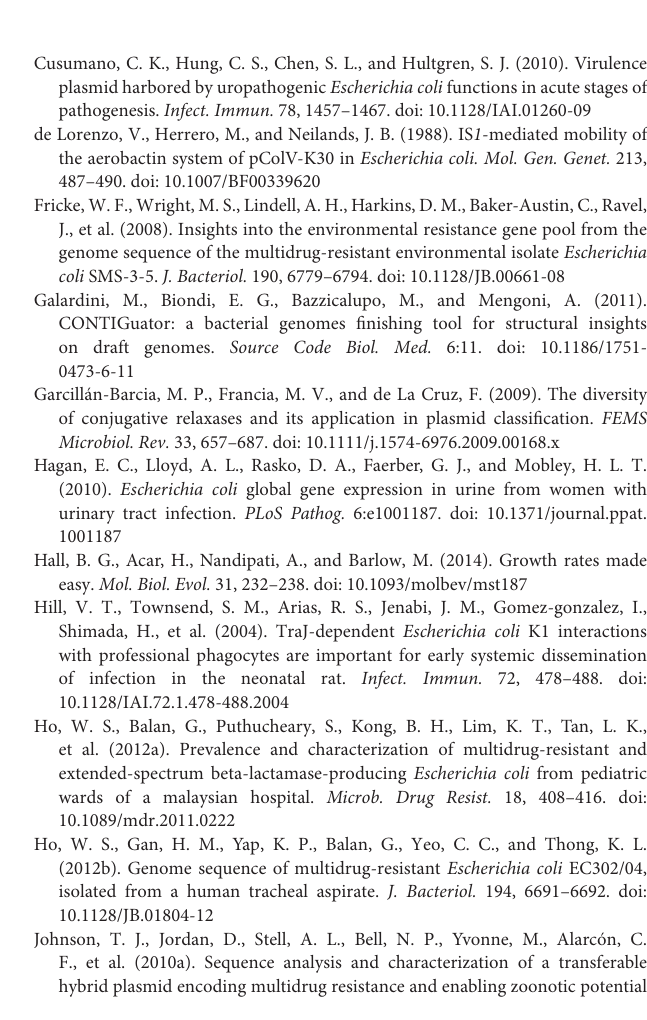
Supplementary Table 1 | Primers used for plasmid pEC302/04 gap closing. Supplementary Table 2 | Iron acquisition systems.